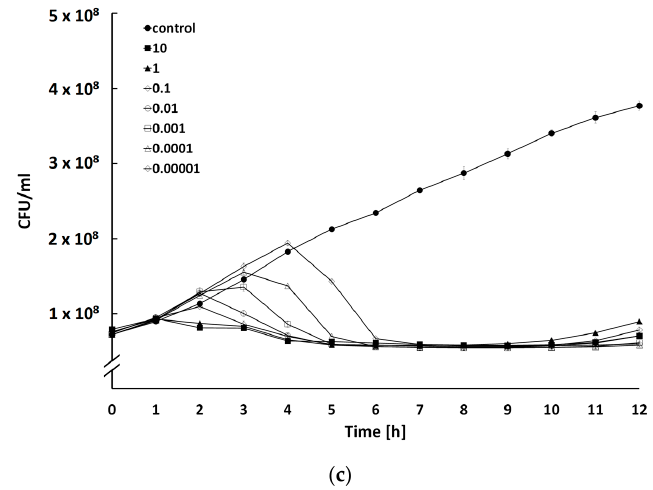
Figure 5. Effects of bacteriophages BF9 ( a ), BF15 ( b ), and BF17 ( c ) on count of the host strain. The strains were treated with phages at different MOIs. Each data point represents the mean and standard deviation of three different experiments.